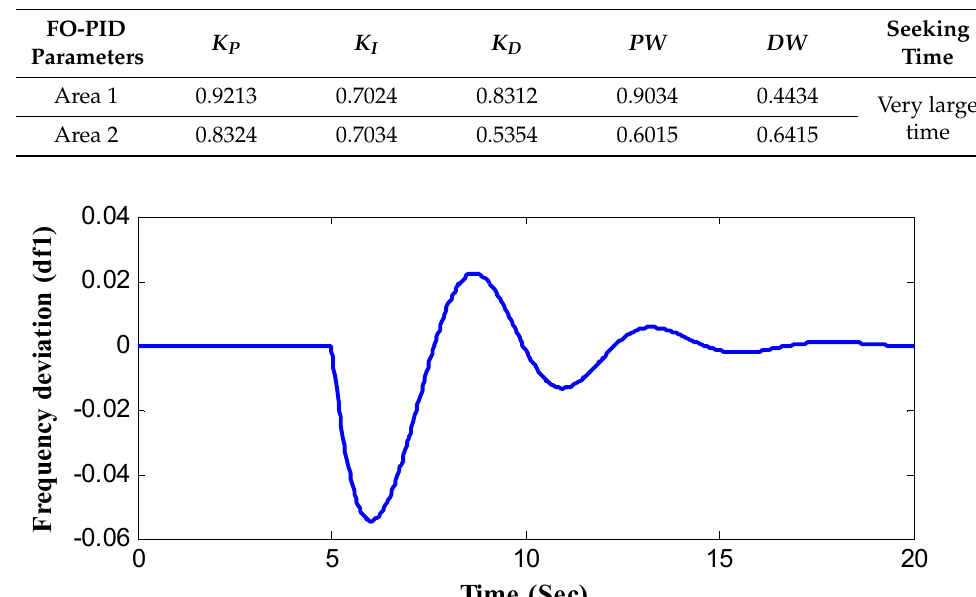
Figure 7. Frequency deviation ( ∆𝑓 (cid:2870) ) using conventional 2DOF-OPID controller Figure 8. Tie-line Power deviation ( Δ P) using conventional 2DOF-PID controller. It is evident from Figures 6 and 7 that the two area have oscillating frequency over a large period of time besides the multiple and large values of undershoots, thus the param- eters of the 2DOF-PID controllers still need to be accurately tuned using high performance objectives and approaches. It is evident also from Figure 8 that the power deviation has multiple and very large overshoots and long settling time and therefore, the parameters of the controllers have to be optimized using powerful approach.